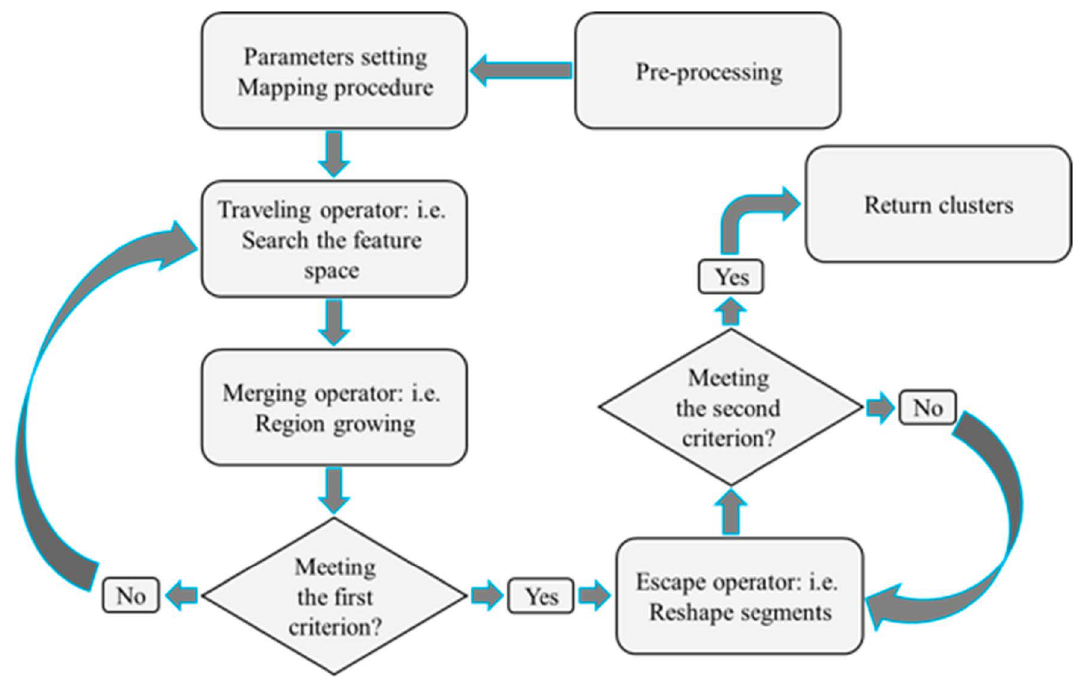
Figure 1. The analytical procedure of homogeneity distance classification algorithm (HDCA).